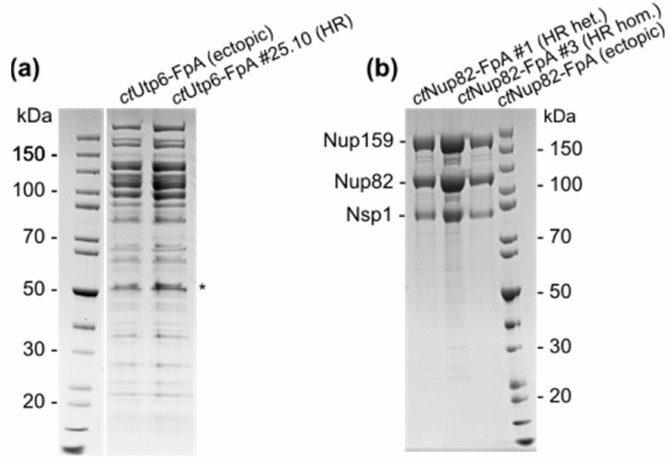
Figure 3. Affinity-purification of in locus C-terminally tagged fusion proteins. Tandem-affinity purification of HR-derived in locus expressed Utp6-FpA- ( a ) and Nup82-FpA fusion proteins ( b ) in comparison to their respective plasmid-based ectopically integrated fusion proteins. The 90S pre-ribosomal particle and native Nup82-subcomplex were purified, respectively. Flag-eluates were analyzed by SDS-PAGE and Coomassie staining. *—bait